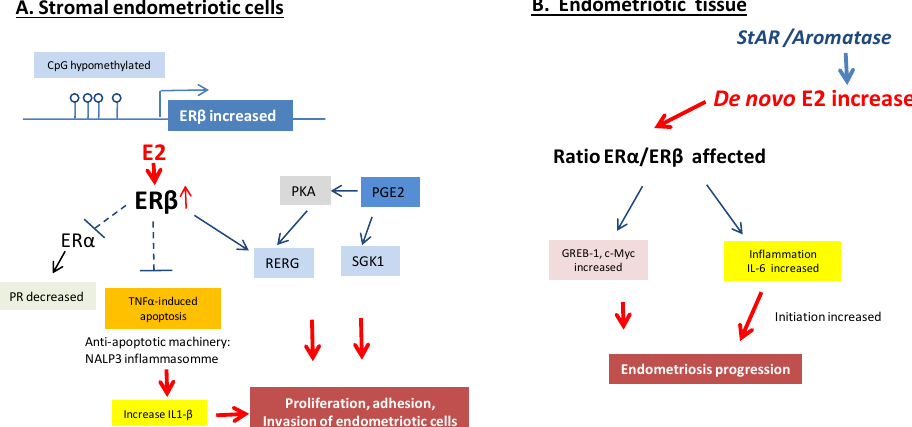
Figure 3. Molecular pathways of ER regulation in endometriosis lesions. ( A ). Overexpression of ERβ in the stromal endometriotic cells inhibits the TNFα-mediated apoptosis, acts as a suppressor of ERα, induces interleukin-1, co-stimulates Ras-related estrogen-regulated growth inhibitor (RERG) and serum and glucocorticoid-regulated kinase (SGK1) as key ERβ targets with co-stimulating prostaglandin E2 (PGE2) under the action of estradiol. ( B ). De novo increase of 17β-Estradiol (E2) in endometriosis lesions affecting the ratio of ERα and ERβ, impacting the inflammation and expression of some target genes such as Greb-1 and c-Myc that results in endometriosis progression [2,27]. However, we must remain cautious about the role of ERβ in endometriosis. Andersson et al. questioned the expression of ERβ in several tissues due to the absence of validation of the anti-ERβ antibody used [66]. Moreover, the comparison of results obtained in different studies was hampered by the use of different methodologies and different endometriotic lesions (ovarian vs. peritoneal endometriosis).